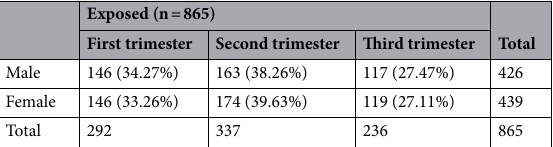
Table 2. Distribution of exposed children by sex and timing of